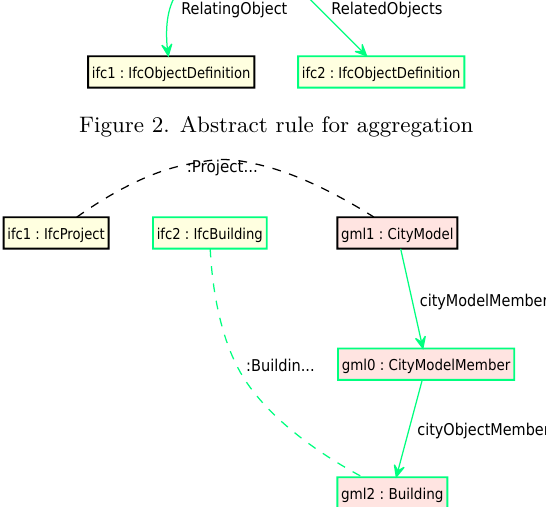
Figure 3. Abstract rule for buildings